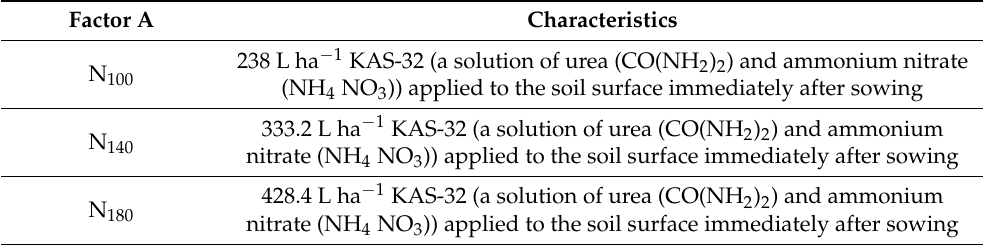
Table 1. Factor A—nitrogen (N) fertilizer rates. Factor A